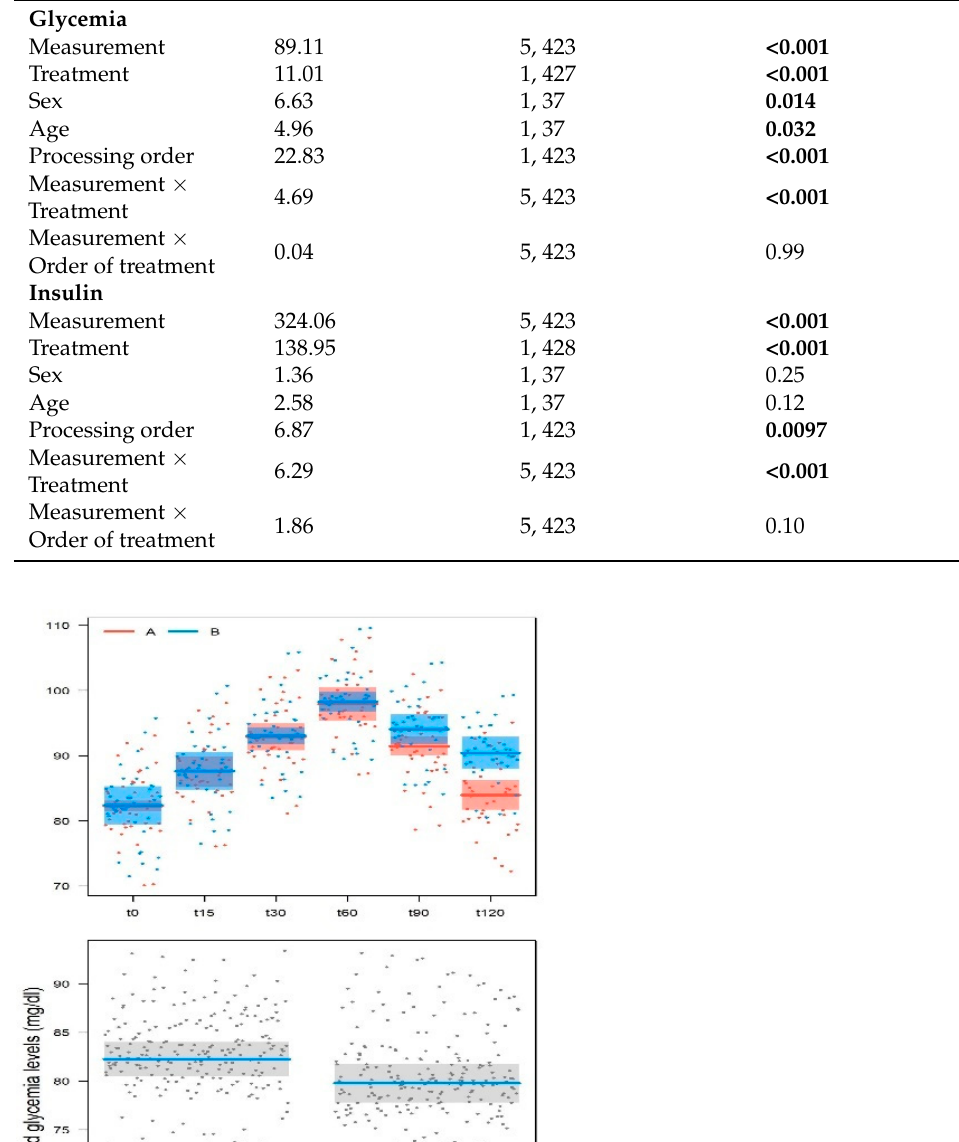
Table 5. LMM model results for glucose and insulinemic response curves.